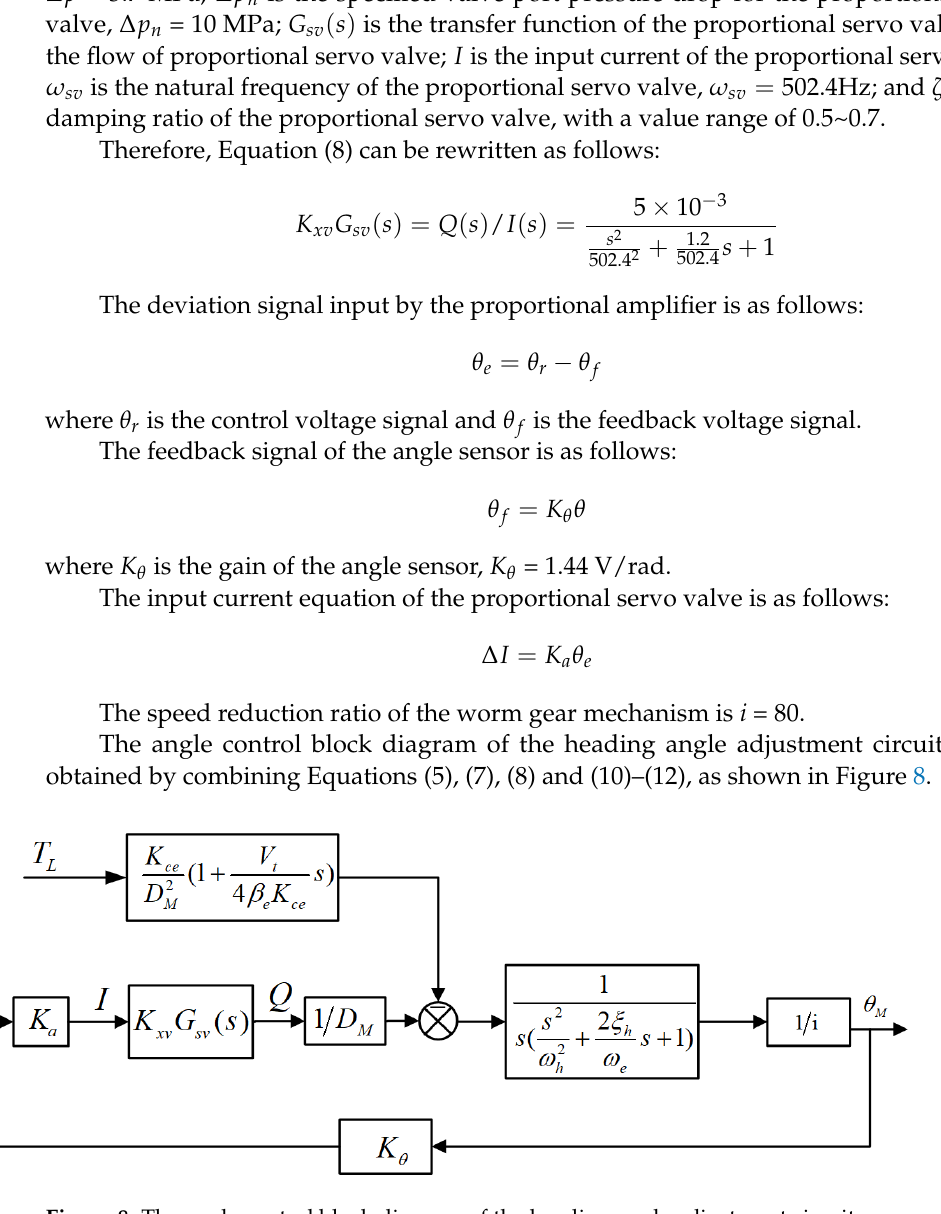
Figure 9. Simplified angle control block diagram of the heading angle adjustment circuit. Therefore, the open-loop transfer function of the output angle  M to the input signal  r of the system is as follows:    ==